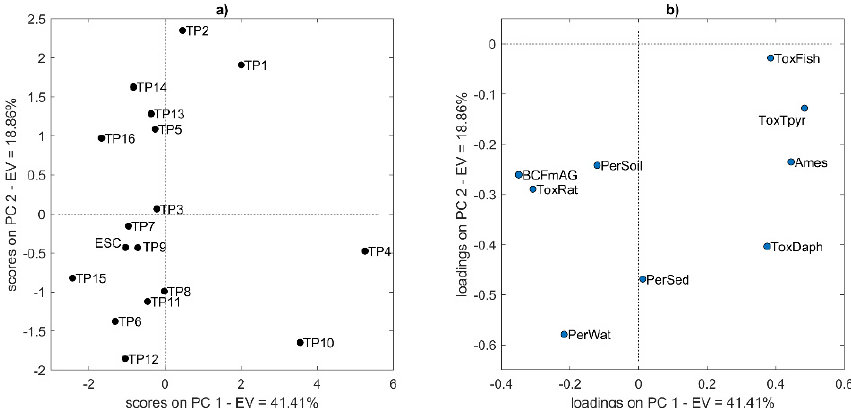
Figure 6. Graphical results of principal component analysis (PCA) of the toxicological and environ- mental fate endpoints for ESC and its detected TPs: ( a ) score plot and ( b ) loading plot of the first two principal components (PCs). The variable labels in the loading plot ( b ) are: acute toxicity on fish (ToxFish), Daphnia magna LC50 (ToxDaph), T. pyriformis IGC50 (ToxTpyr), oral toxicity on rat LD50 (ToxRat), mutagenicity by Ames test (Ames), log bioconcentration factor (BCFmAG), water persistence (PerWat), sediment persistence (PerSed), and soil persistence (PerSoil). Further details on variables are given in the supplementary material (Table S2).